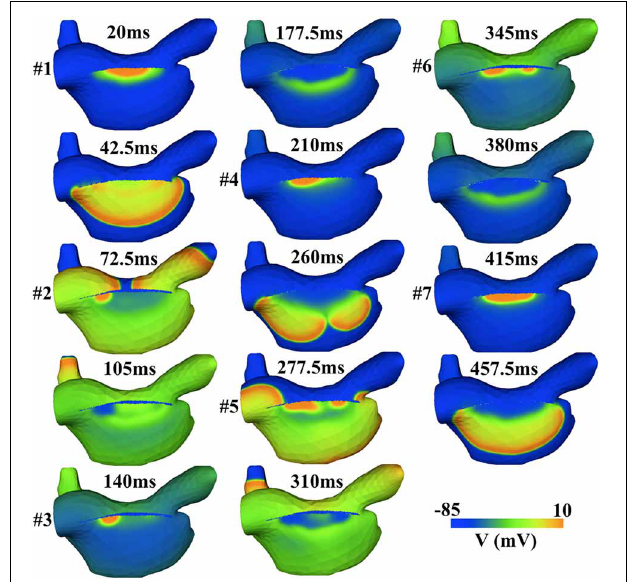
FIGURE 13 | Simulated irregular SAN and atrial excitation patterns induced by the weak SAN-atrial coupling in a 3D atrial model. Only 3 (#1, #4, and #7) out of 7 SAN excitations successfully activate the atrial